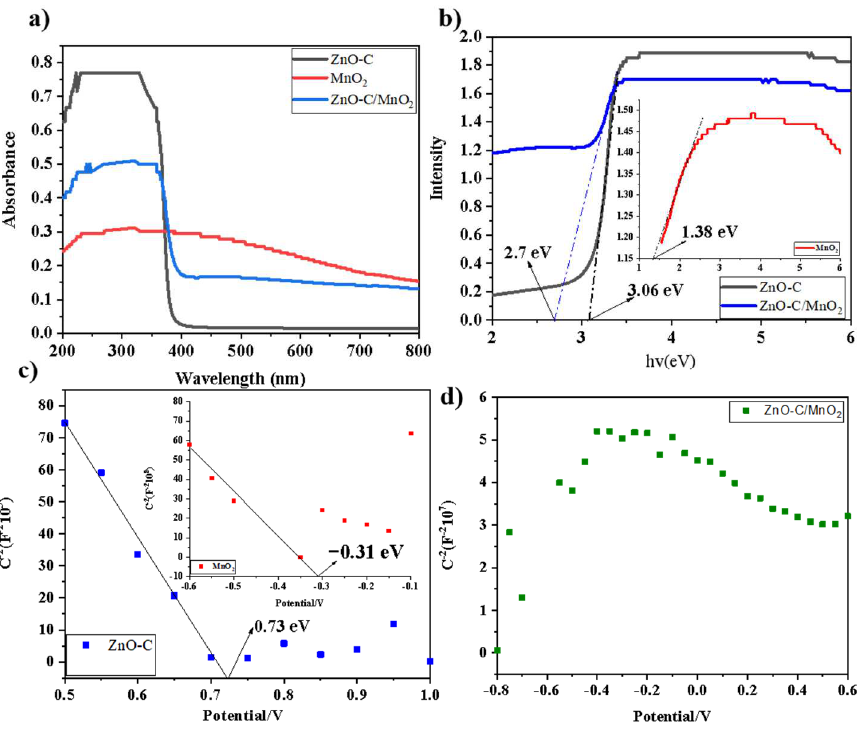
Figure 4. UV‐vis spectra of ZnO‐C nanospheres ( a ), MnO 2 nanowires and ZnO‐C/MnO 2 heterojunction ( b ) and M‐S of ZnO‐C nanospheres, MnO 2 nanowires ( c ) and ZnO‐C/MnO 2 ( d